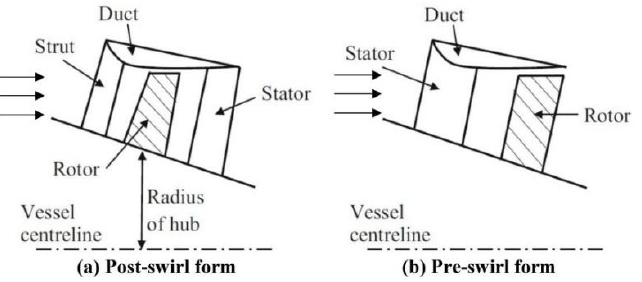
Figure 1. Schematic diagram of two types of pump-jets [3].